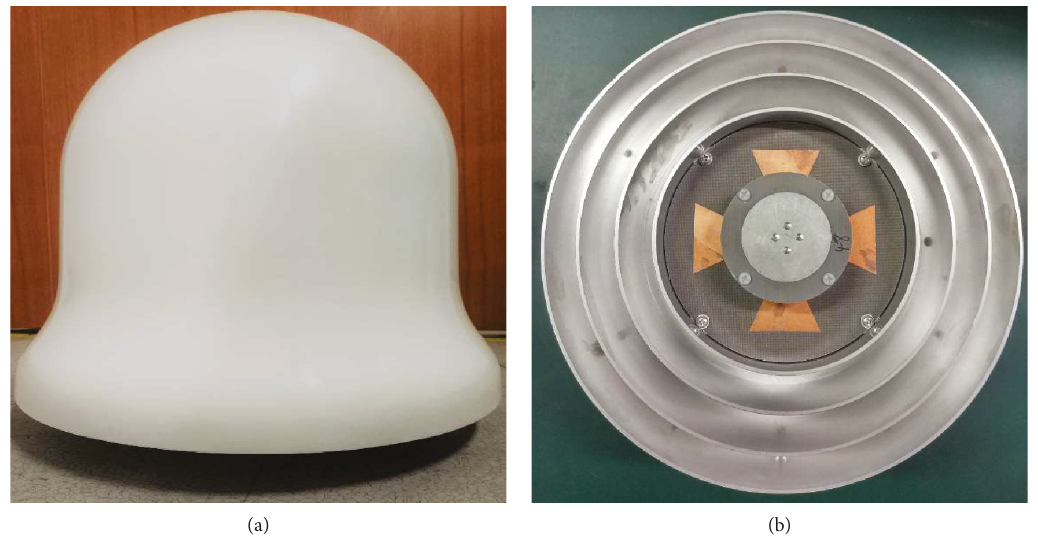
Figure 7: Photograph of fabricated proposed (a) radome and (b)